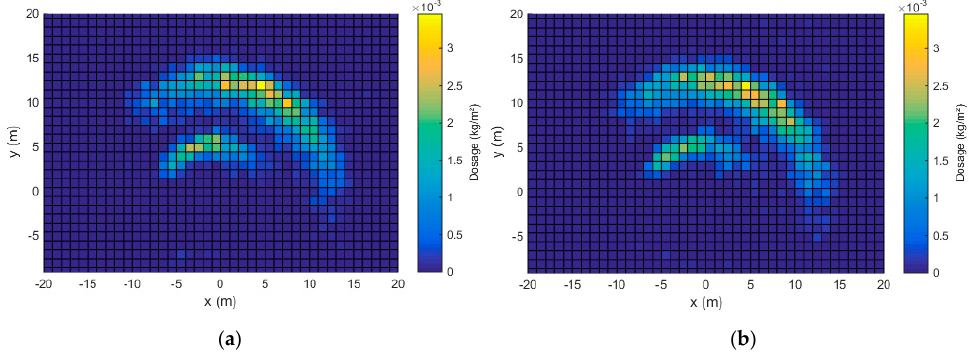
Figure 10. Static spread pattern, configuration B, test 1 ( a ) and test 2 ( b ). Table 7. Correlation coefficients between two replicates of the static spread pattern as calculated